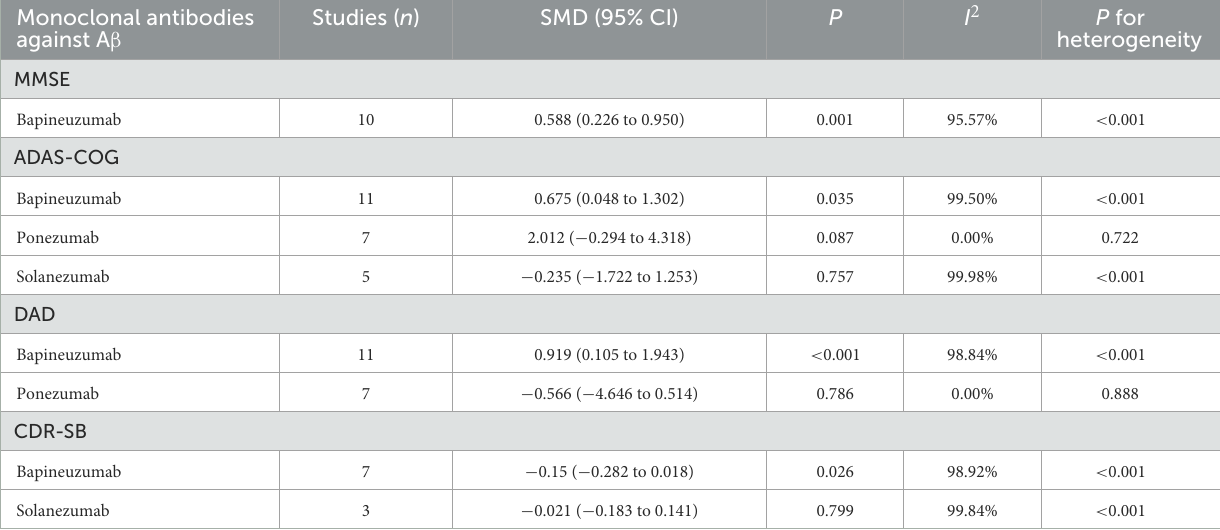
TABLE 3 Drug-specific comparisons of four assessment scales associated with mild or moderate AD. Monoclonal antibodies Studies ( n against A β